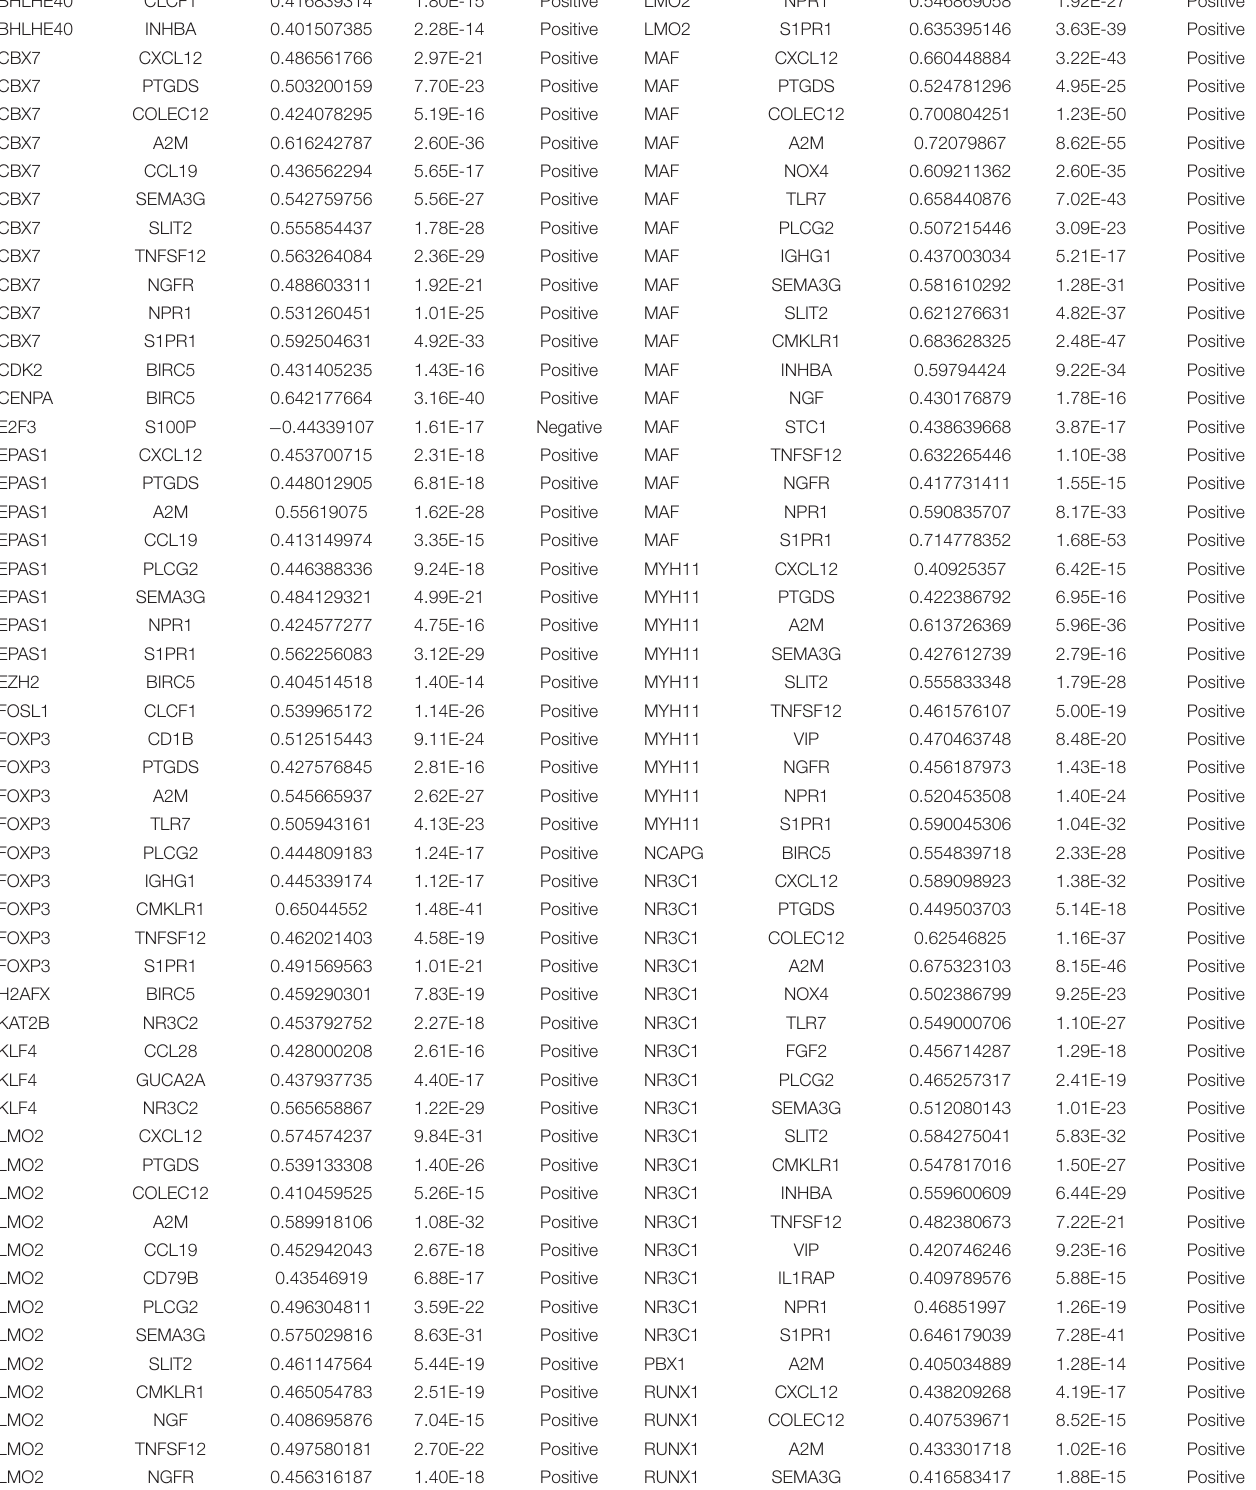
TABLE 2 | Correlation between prognostic IRGs and